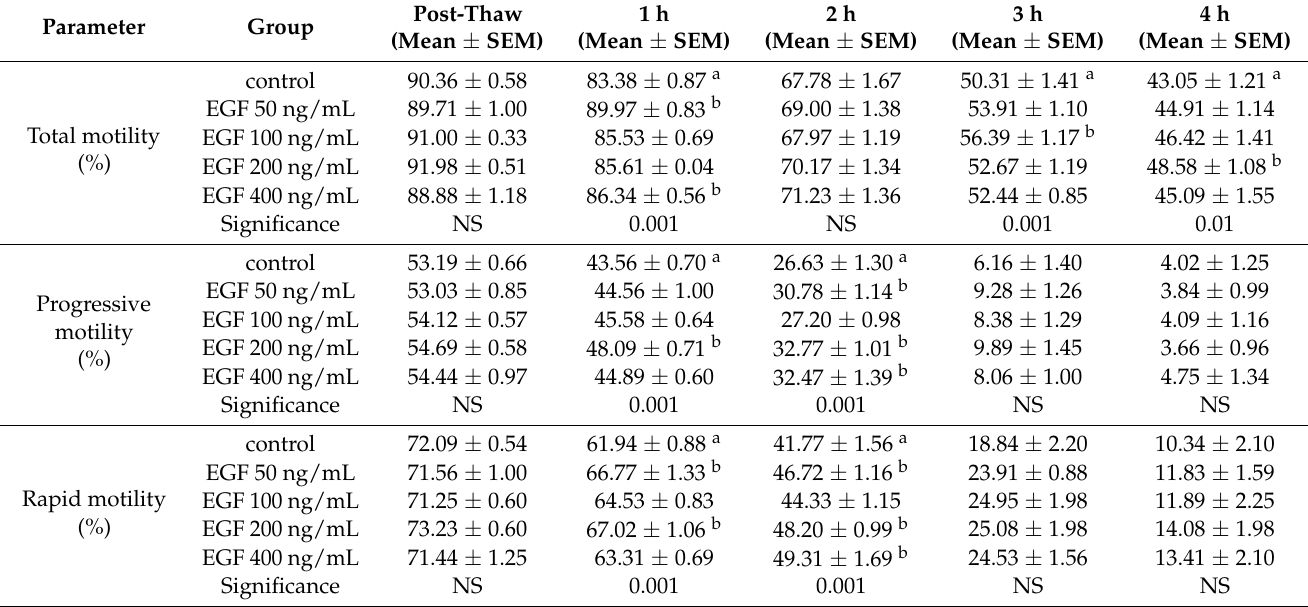
Table 2. Differences in motility parameters (total, progressive, and rapid) between thawed semen extended with epidermal growth factor (EGF) at different concentrations (50, 100, 200, and 400 ng/mL) and controls (without EGF) at different post-thaw times (n = 8 replicates).